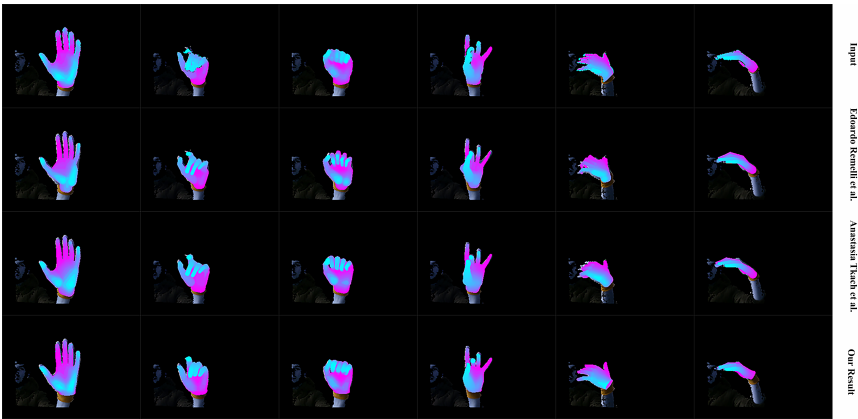
Figure 27. The qualitative comparison between our system with Remelli et al. [39] and Tkach et al. [40] on the Handy/GuessWho sequence of user4. The first row shows the hand segment of the input depth after pseudo-color enhancement; the second row shows the rendered depth image from the recovered hand model of Remelli et al. [39]; the third row shows the rendered depth image from the recovered hand model of Tkach et al. [40]; the bottom row shows the rendered depth image from the recovered hand model of our system.